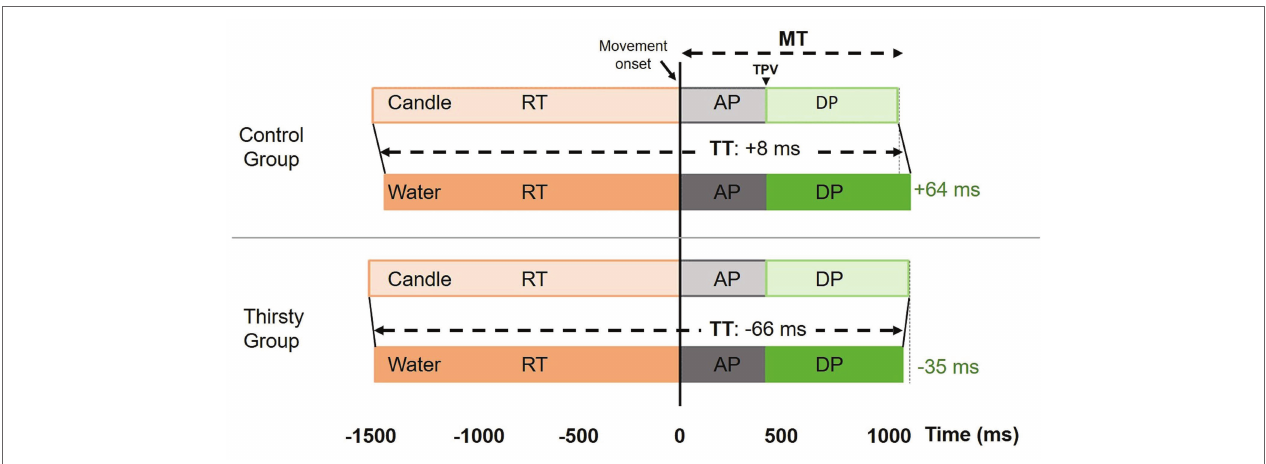
FIGURE 2 | Kinematic parameters were illustrated for both groups (control vs. thirsty) and both glasses (candle vs. water) in go trials. In the control group, the TT was similar for both glasses with an increase of DP when the glass is filled with water compared with candle. In the thirsty group, the glass filled with candle leads to a significant reduction of TT due to both a reduction of RT combined with a reduction of DP. RT, Reaction time; MT, Movement time; TPV, Time to peak velocity; AP, Acceleration phase; DP, Deceleration phase, TT, Time task to perform the movement, from go-signal to glass grasp. All movements were aligned with the movement onset.